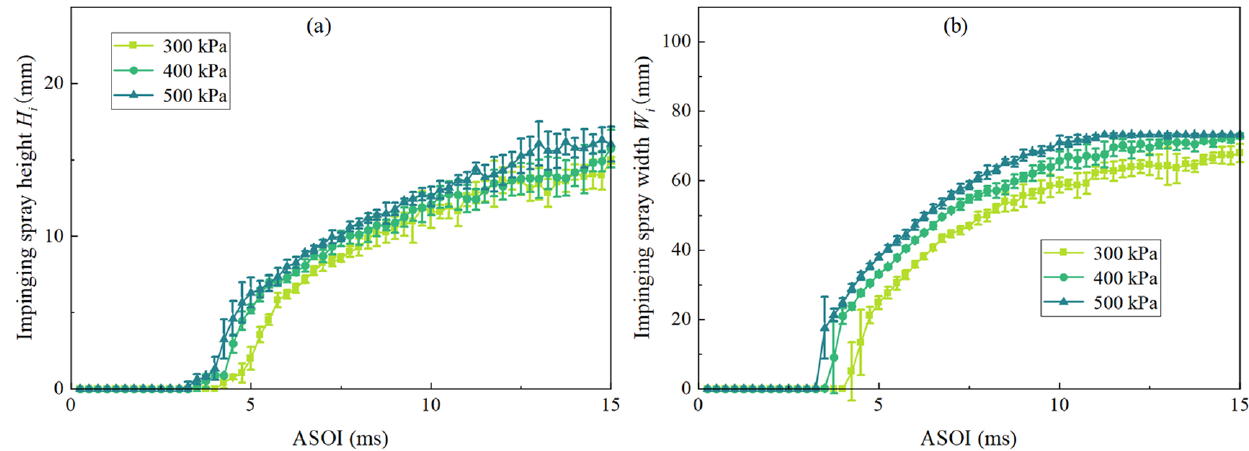
H and ( b ) width W of impinging spray under different Figure 11. ( a ) Impinging spray height H i and ( b ) width W i of impinging spray under different P inj . Figure 11. ( a ) Impinging spray height i i P . Further, the contribution indices were used to quantitatively analyze the boundary inj conditions, say the influence of D imp , T wall , and P inj on H i and W i [14,29]. The contribution index was calculated as Equation (4),